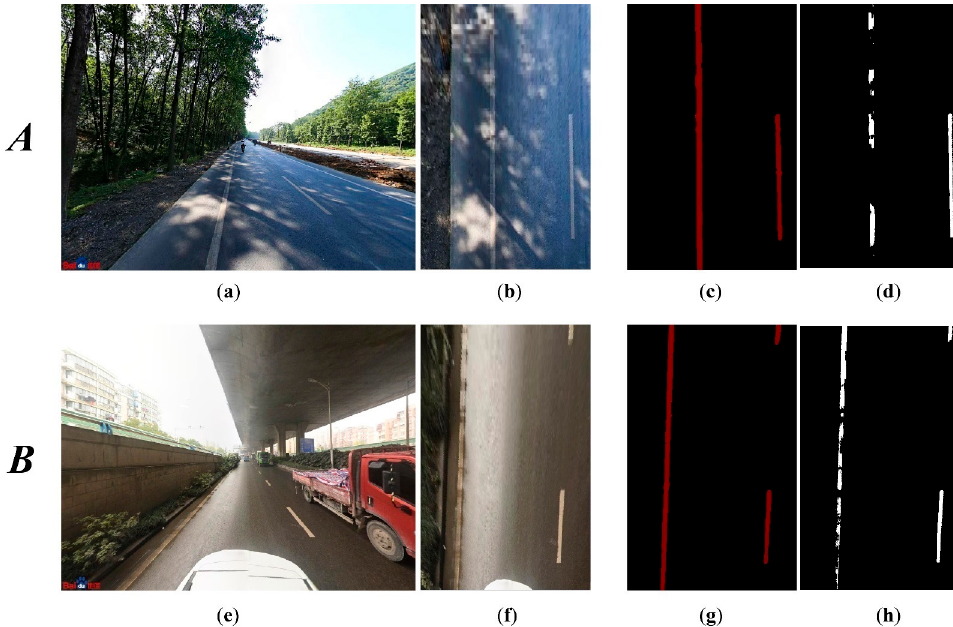
Figure 15. Examples of misjudgments on street-view imageries shot in bad conditions. A Shadow interference on the path, B Interference caused by poor lighting and surface water, ( a , e ) are original images of A and B , ( b , f ) are the birds’-eye-view images of A and B , ( c , g ) are the recovered part of pavement markings of A and B predicted by the DeepLab V3+ model, ( d , h ) are the undamaged part of pavement markings of A and B extracted by a local threshold, which has a large discrepancy from the real situation in panel ( b , f ).